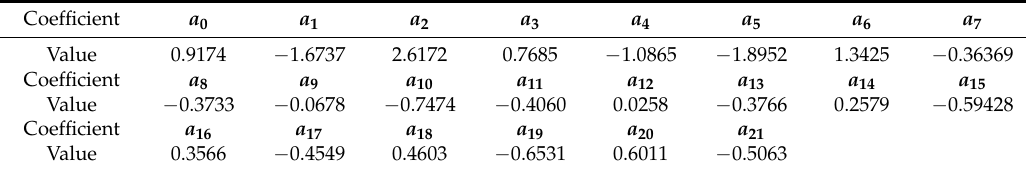
Table 5. Coefficients of Equation (13).